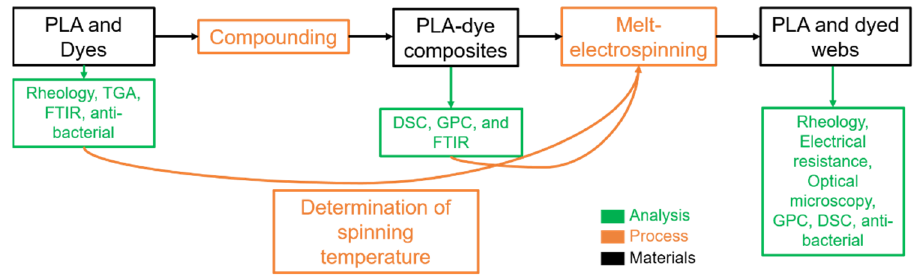
Figure 3. Overview of the experimental